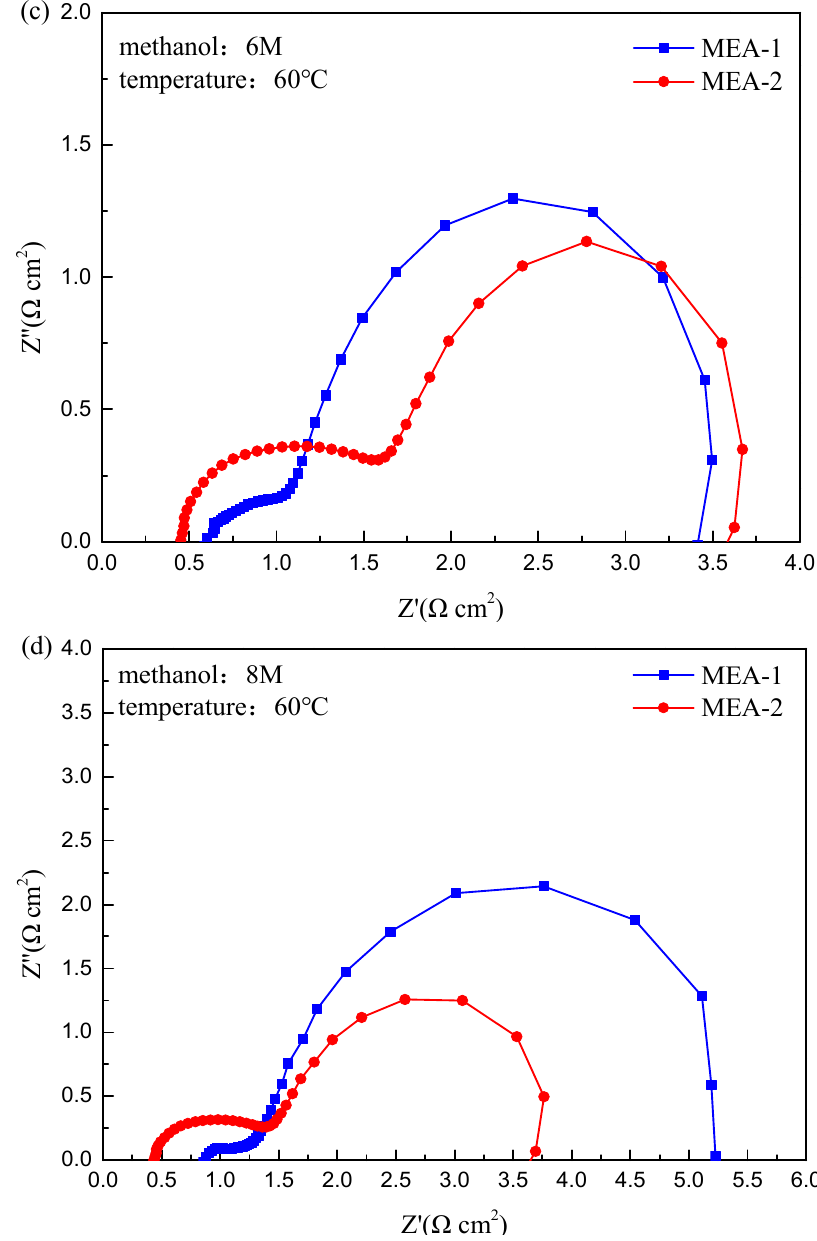
Figure 5. Comparison of Nyquist plots of two electrodes at different concentrations.